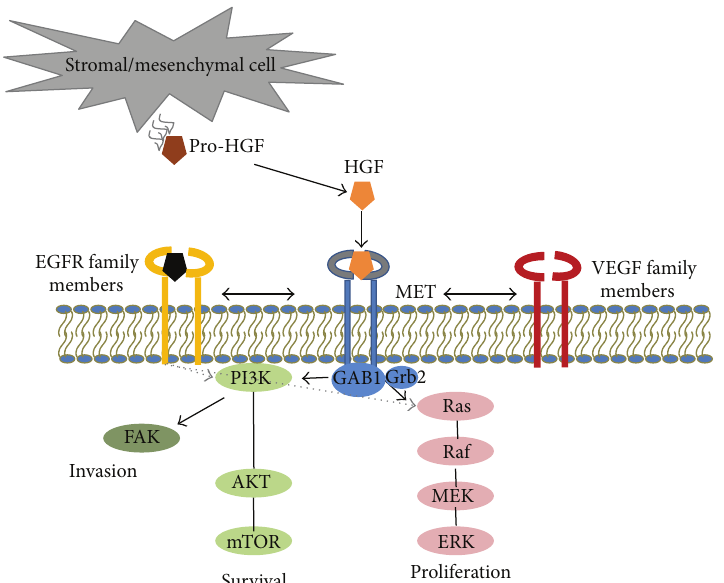
Figure1:Thehepatocytegrowthfactor-(HGF-)cMETaxis.Thehepatocytegrowthfactor(HGF)interactswithcMETviaaparacrinesignaling loop and mediates the epithelial-mesenchymal transition. Pro-HGF is secreted by stromal and mesenchymal cells and undergoes proteolytic activation into HGF. HGF binds to the MET receptor on epithelial cells and induces transautophosphorylation and binding of adaptor proteins. These provide scaffolding for recruitment of other signaling proteins and activation of signaling pathways resulting in increased invasion and motility, survival, proliferation, and stimulation of angiogenesis. Crosstalk between EGFR, cMET, and VEGF pathways is also implicated in promoting tumor survival. EGFR: epidermal growth factor receptor; FAK: focal adhesion kinase; Grb2: growth factor receptor- bound protein 2; GAB1: Grb2-associated binding protein; MEK, mitogen-activated protein kinase/ERK kinase; PI3K: phosphoinositide 3- kinase; mTOR: mammalian target of rapamycin; RAS: renin-angiotensin system; VEGF: vascular endothelial growth